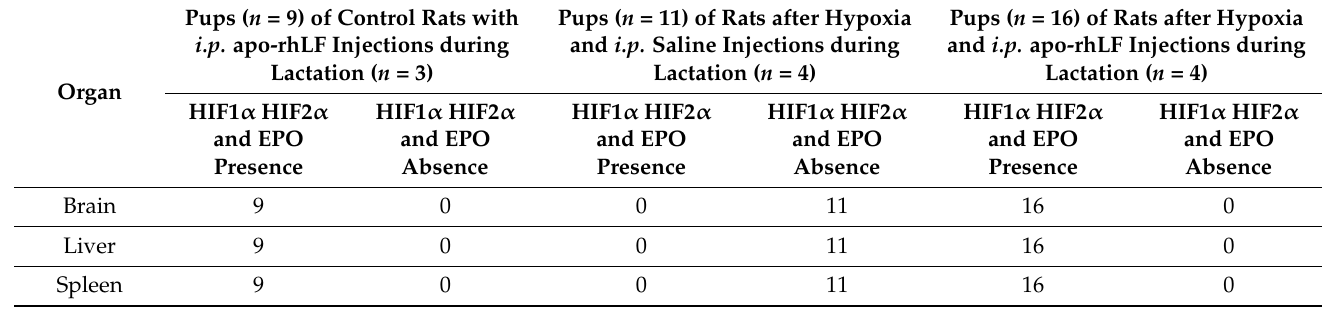
Table 3. HIF-1 α , HIF-2 α and EPO detection by Western blotting in organs of pups. Pups ( n = 9) of Control Rats Organ